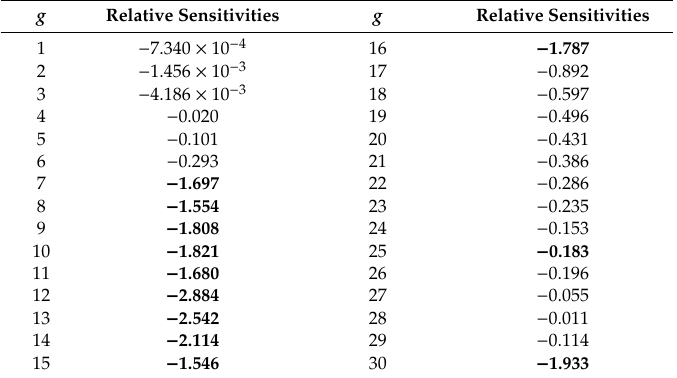
Table 10. Second-Order Relative Sensitivities S ( 2 ) g Relative Sensitivities g